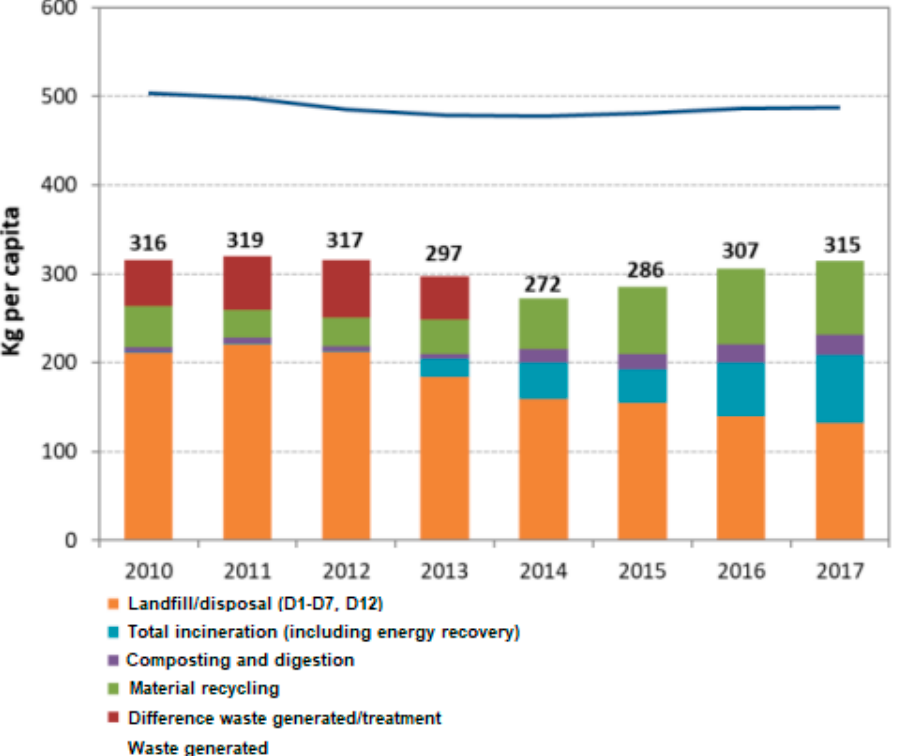
Figure 1. Ways for plastic waste management in Poland between 2010 and 2017 adapted from the European Commission, Eurostat, Municipal waste by waste operations.